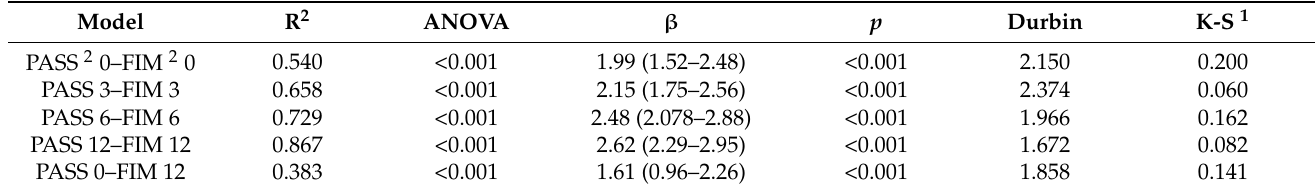
Table 2. Linear Regression Results